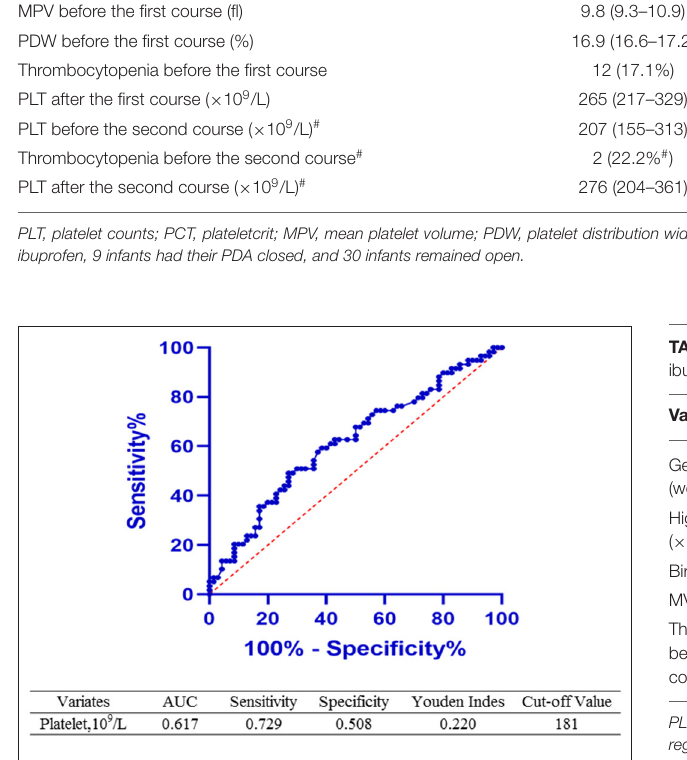
while no statistical significance was reached ( p = 0.062).